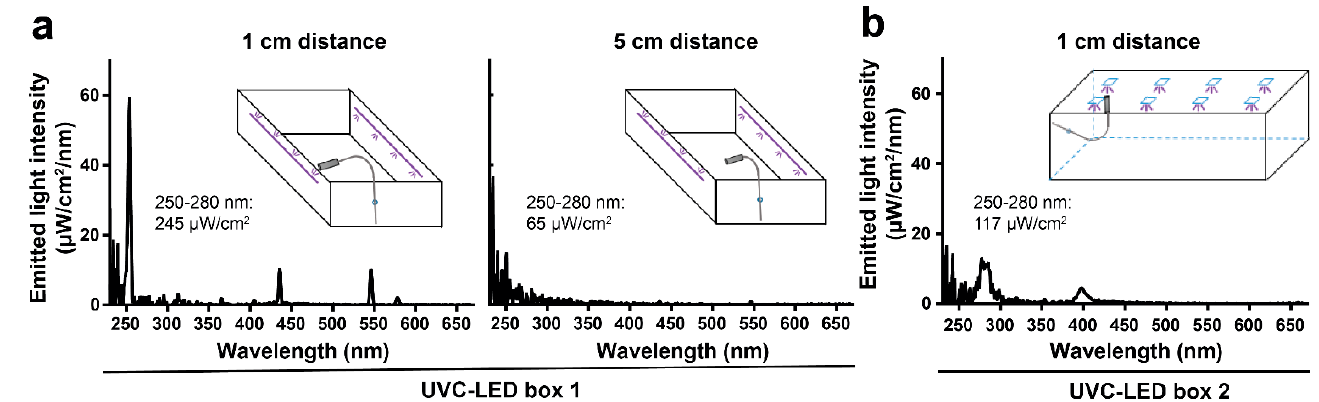
Figure 2. Spectrum of the emitted light intensity by LEDs inside of the UVC-LED boxes. The emitted light energy was measured by using a radiometrically calibrated spectrometer (STS-UV-L-50-400-SMA, Ocean Optics B.V., Ostfildern, Germany) with a sensitivity range between 190 and 650 nm (1.5 nm resolution) equipped with a CC-3-UV-S corrector (Ocean Optics B.V., Ostfildern, Germany). ( a ) The spectrum of emitted light intensity of UVC-LED box 1 was measured at 1 and 5 cm horizontal distance from the lateral UVC-LEDs. ( b ) The spectrum of emitted light intensity of UVC-LED box 2 was measured at 1 cm vertical distance from the UVC-LEDs. Emitted light intensity (µW/cm 2 ) between 250 and 280 nm is displayed for each spectrum. Schematic illustrations indicate the borehole and the UVC-detector placed inside of the box for the respective measurement.